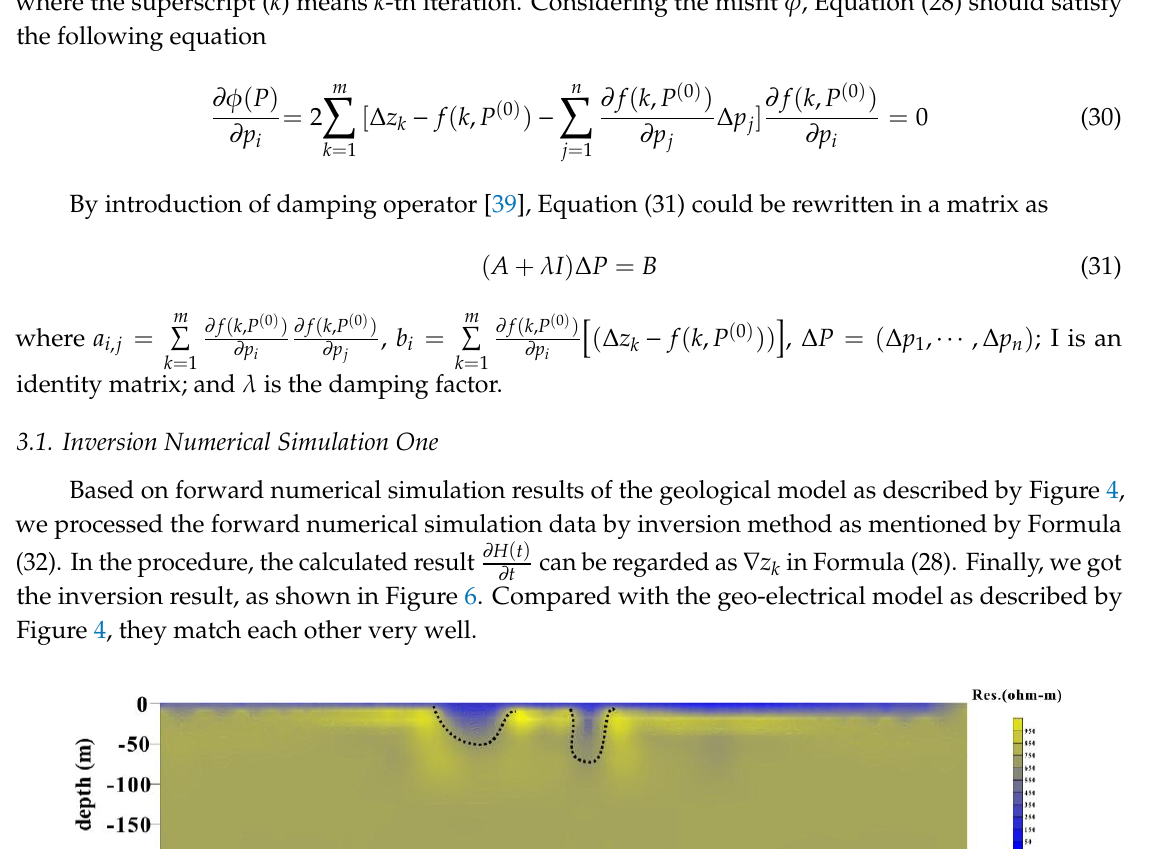
Figure 7. Inversion result of geo-electrical model with terrain. 4. Conclusions Railway construction in Western China is very important for economic development. However, the permafrost problem has always plagued the railway construction. It was imperative to explore the distribution of permafrost by geophysical methods to prevent potential geological disaster. According to the terrain characteristics of the Qinghai–Tibet Plateau, a new airborne transient electromagnetic method was developed to investigate two kinds of two geo-electric models: one was flat ground surface, and the other one was undulating ground surface. To achieve forward simulation, a new algorithm that calculated the airborne transient electromagnetic responses was proposed, and the detailed characteristics of the calculated electromagnetic responses of the geo-electrical models were presented. For the purpose of estimating the distribution of the permafrost using the forward modeling data, a coupling function based on the least squares was constructed to fit the observation data and the calculation data. The calculation results of the two simulation models demonstrated that it was feasible to solve the permafrost problem of Qinghai– Tibet Plateau in Western China by the proposed airborne transient electromagnetic method. The location and degree of the permafrost in the simulated models could be effectively recognized. In future plans, the proposed method will be further verified by field data. Author Contributions: Conceptualization, J.Y. and Z.L.; methodology, B.S. and R.R; Data collection, R.R., L.S. and Z.L.; Analysis, B.S., R.R., and L.S.; writing—original draft preparation, B.S. and Z.L.; writing—review and editing, Z.L. and J.Y. All authors have read and agreed to the published version of the manuscript.